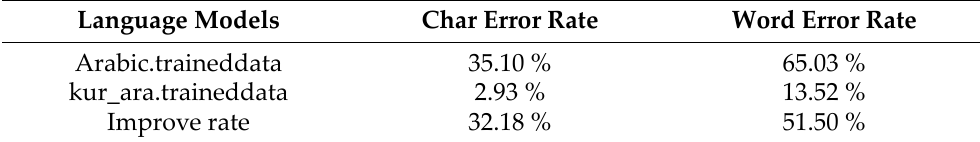
Table 11. The evaluation result of trained language model with the starter language model.